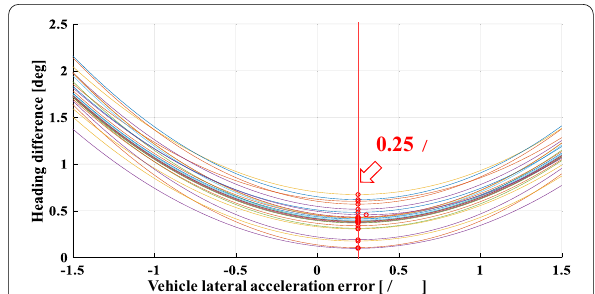
Fig. 4 Estimation results of the lateral acceleration error